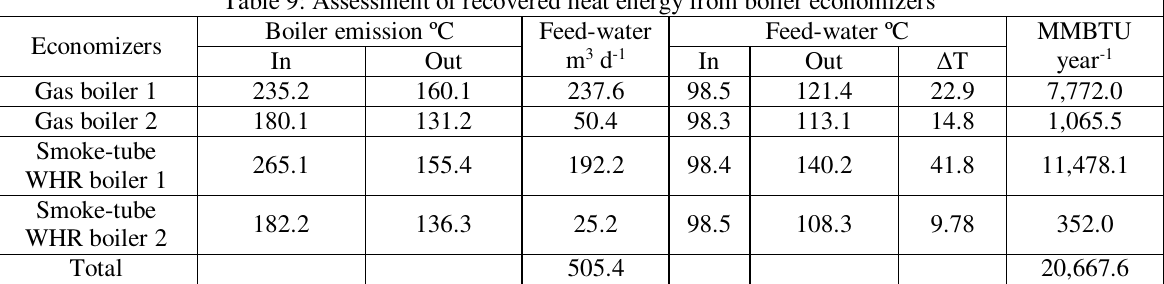
Table 9: Assessment of recovered heat energy from boiler economizers